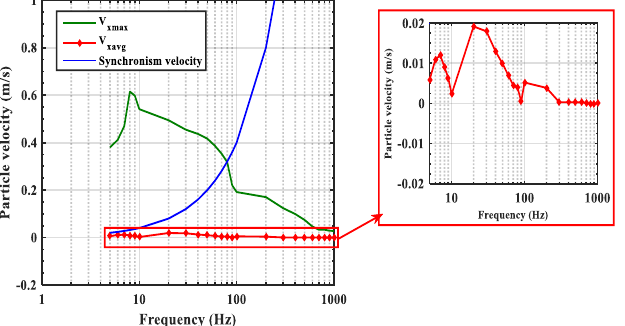
Figure 7. Evolution of the particle’s average and maximum velocities as a function of the frequency. Conditions: 𝑉 = 1000 V, 𝑑 𝑝 = 60 μm, 𝑞 𝑝 = 10% 𝑞 𝑝𝑠 , 𝑥 0 = 4.3 mm, t = 1 s. Figure 8 represents the particle trajectories for different frequency values (10 Hz, 20 Hz, 50 Hz, and 500 Hz). The conditions of the simulation are: 𝑉 = 1000 V, 𝑑 𝑝 = 60 µm, 𝑞 𝑝